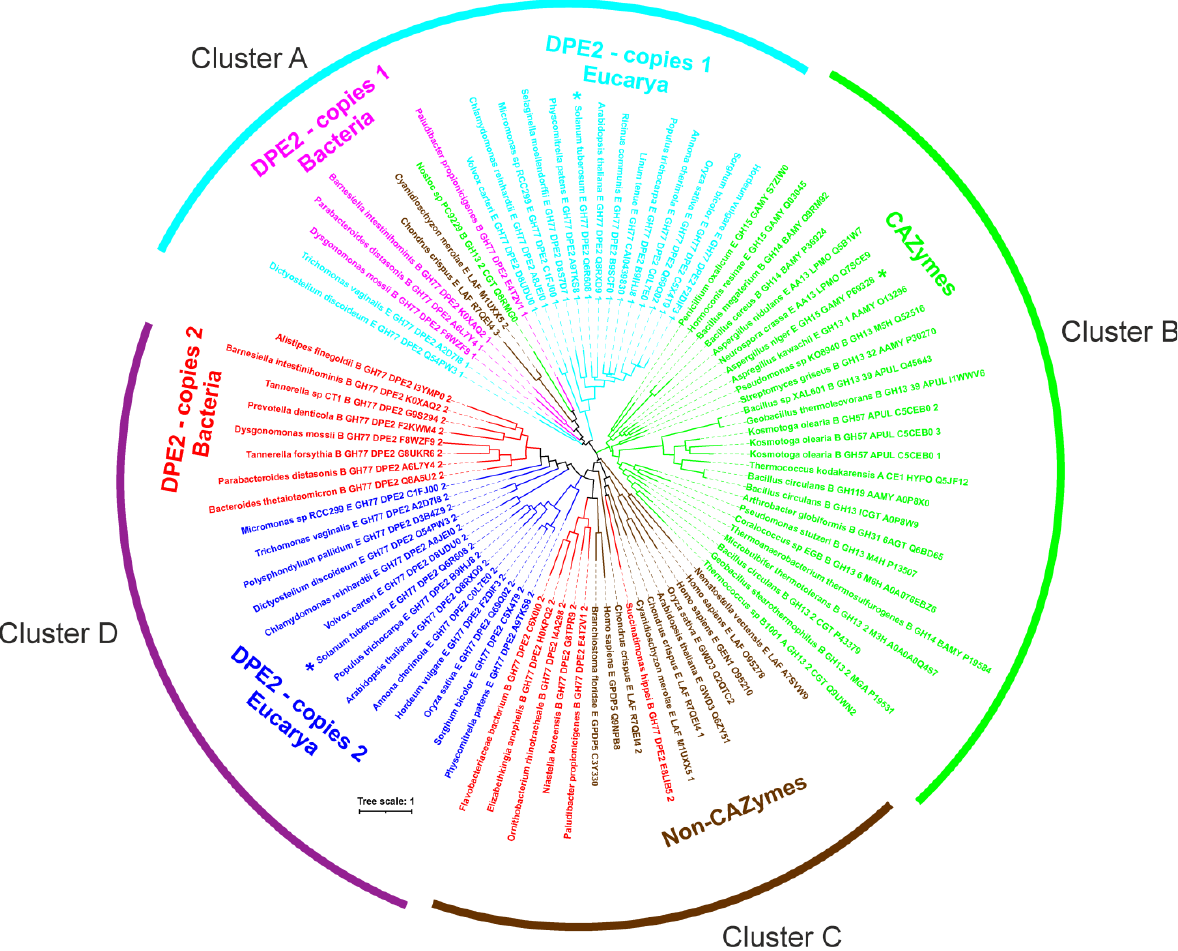
Figure 2. Phylogenetic tree of CBM20s with focus on GH77 DPE2s. The tree is based on the